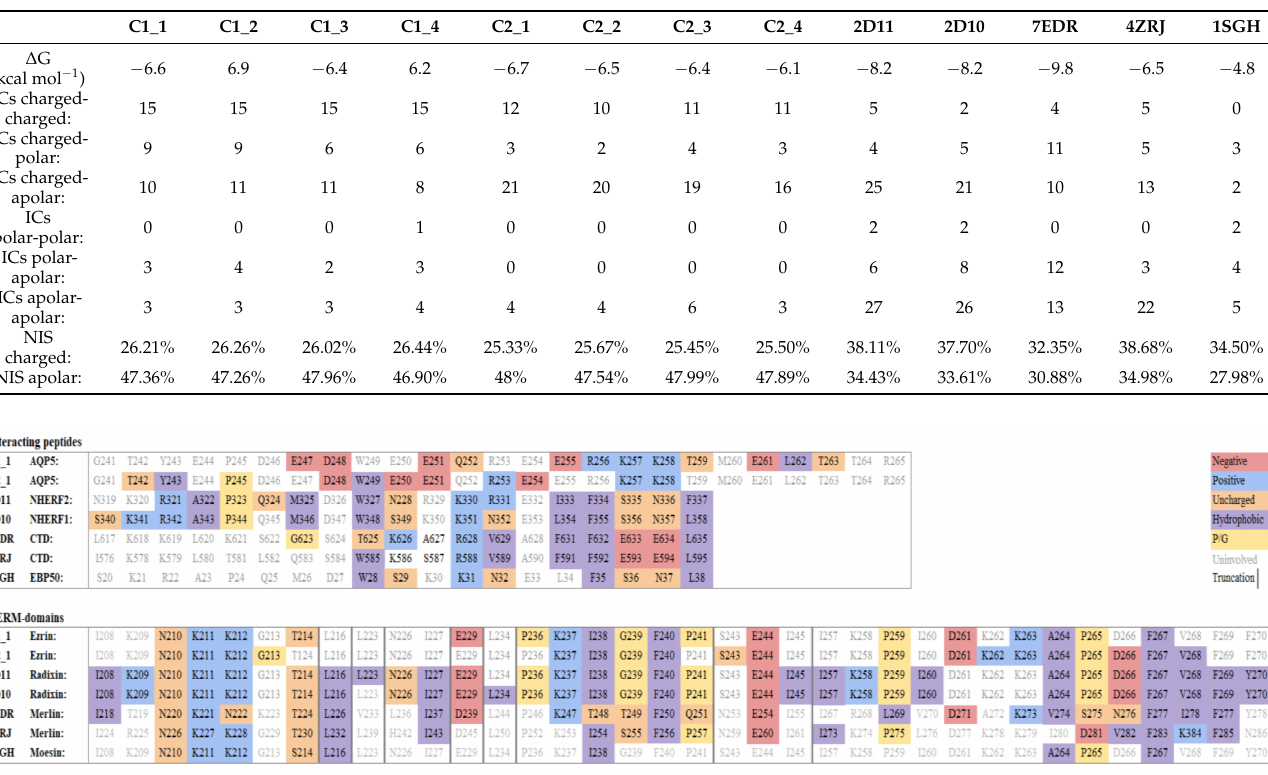
Table 2. PRODIGY interaction statistics for Cluster1_1-1_4 (model 1, comparative modeling), Cluster2_1-2_4 (model 2, fTrRosetta), and crystal structures of other complexes between alpha helical peptides and FERM domains (2D11 and 2D10: Mus musculus radixin FERM with NHERF-2 and NHERF-1 peptides, respectively; 7EDR: Drosophila melanogaster Merlin FERM with Merlin C-terminal domain; 4ZRJ: Human Merlin with C-terminal domain; 1SGH: Human Moesin FERM with EBP-50 (also known as NHERF-1).